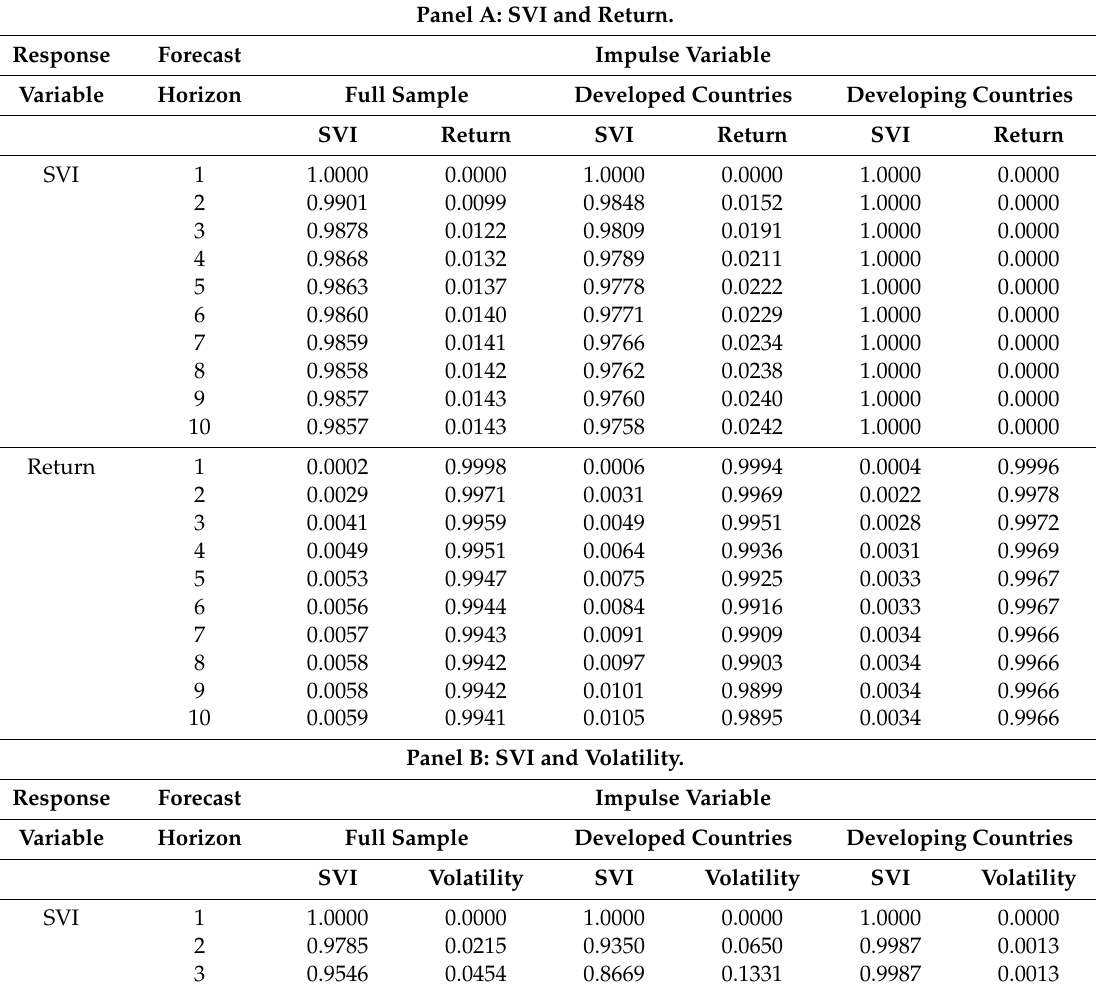
Table 3. Variance decomposition. Panel A: SVI and